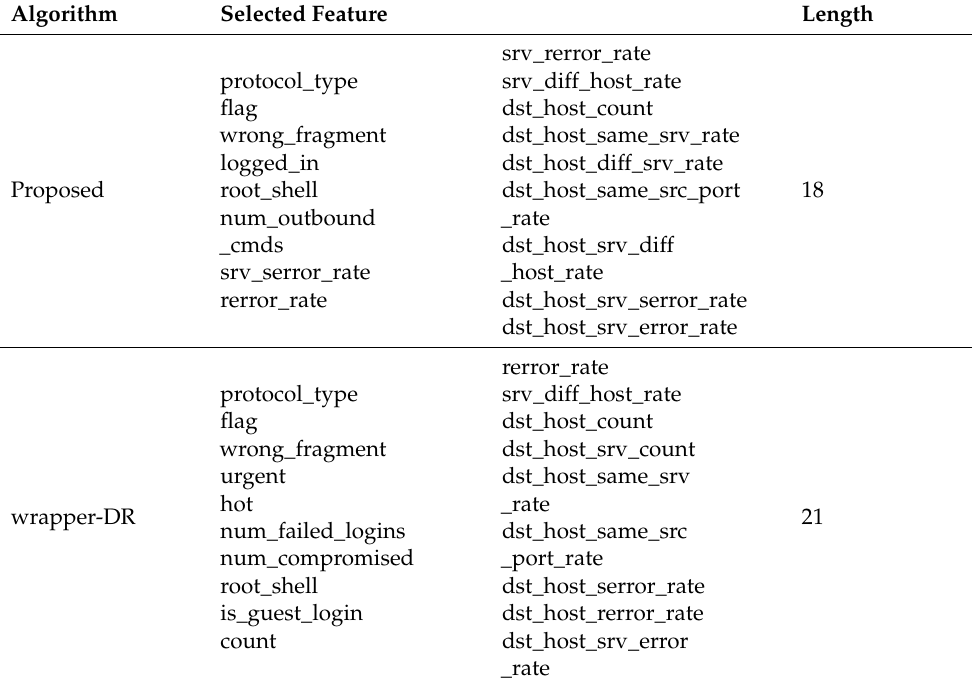
Table 7. Result of selected features by feature